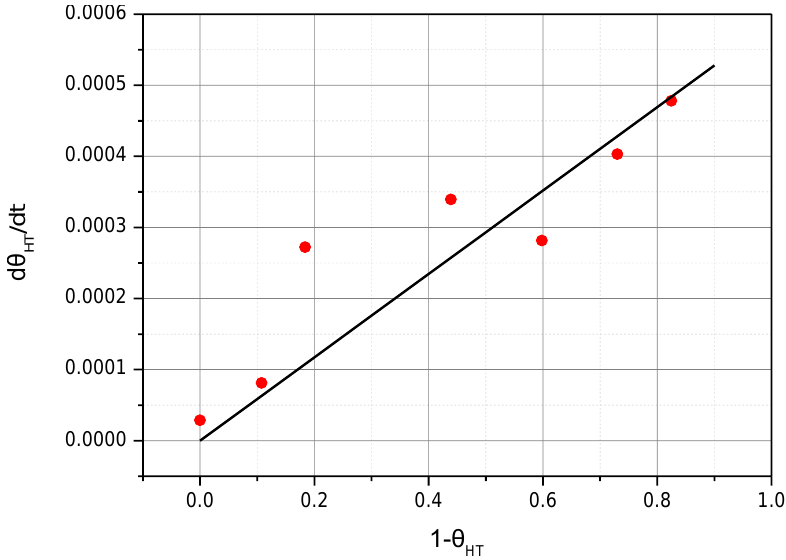
Figure 8. The relationship of d θ HT /dt and 1 − θ HT (inlet NH 3 concentration: 200 ppm, temperature of NH 3 absorbing: 50 °C).